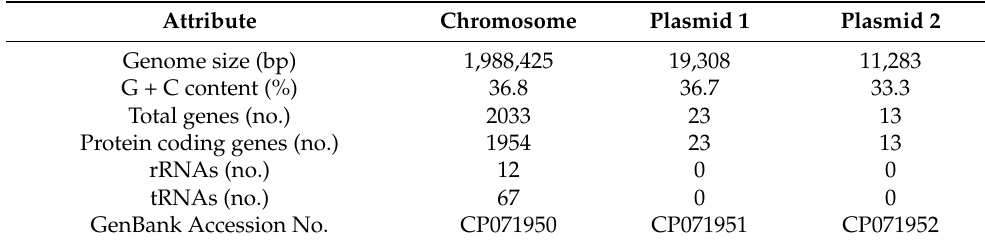
Table 6. General genomic features of L. aenigmaticum